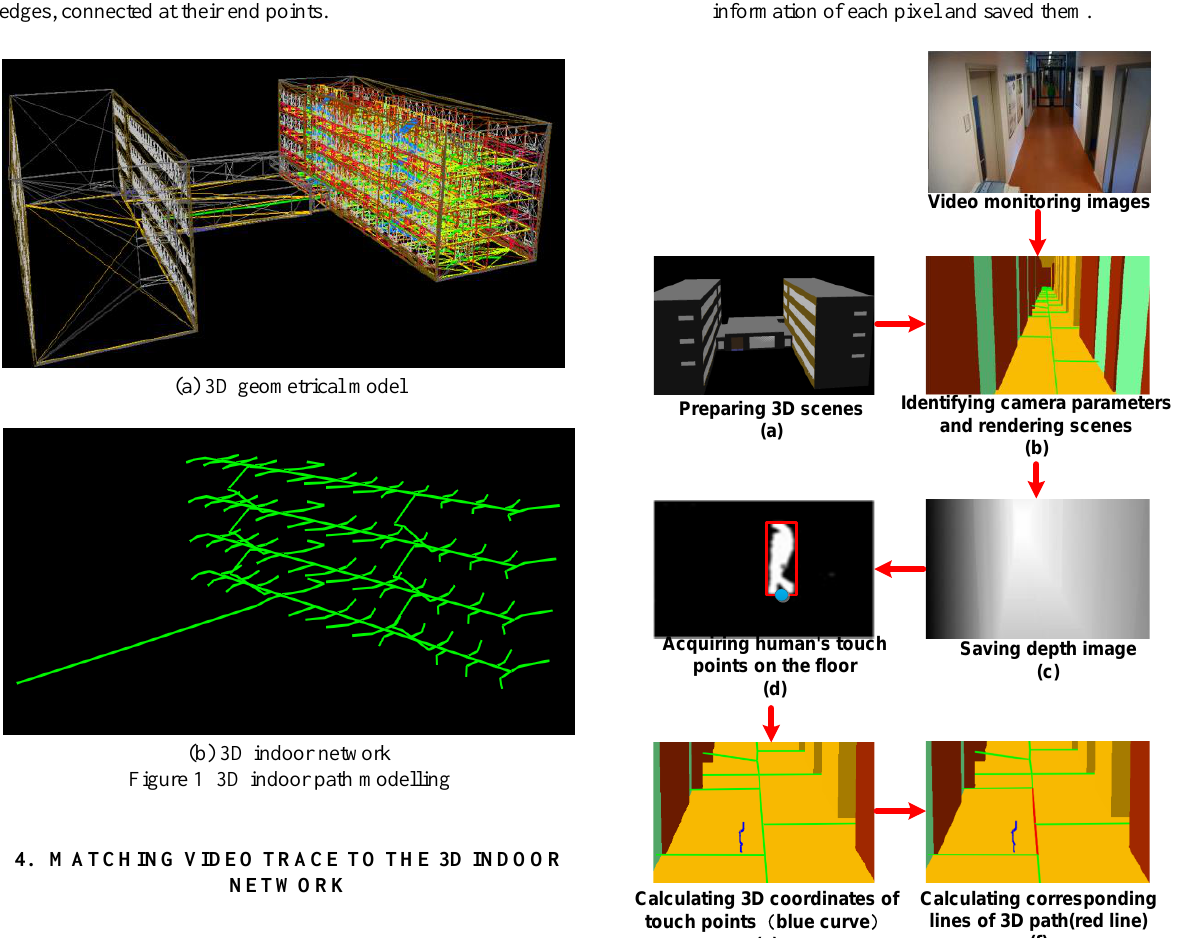
Figure 2 Matching traces to 3D indoor